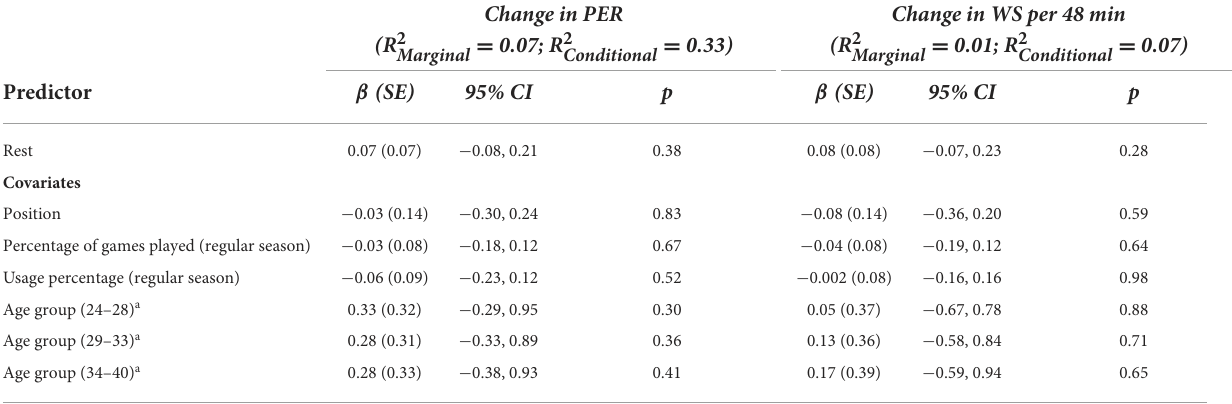
TABLE 3 Linear mixed-effects model results for change in player efficiency rating (PER) and win shares (WS) per 48min. Change in